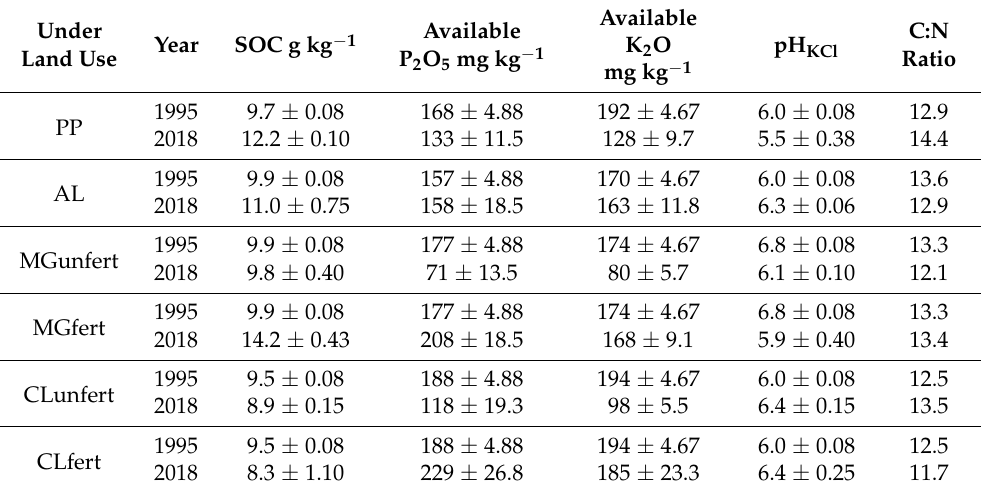
Table 2. Arenosol topsoil (0–25 cm) chemical properties (1995 and 2018). Under Land